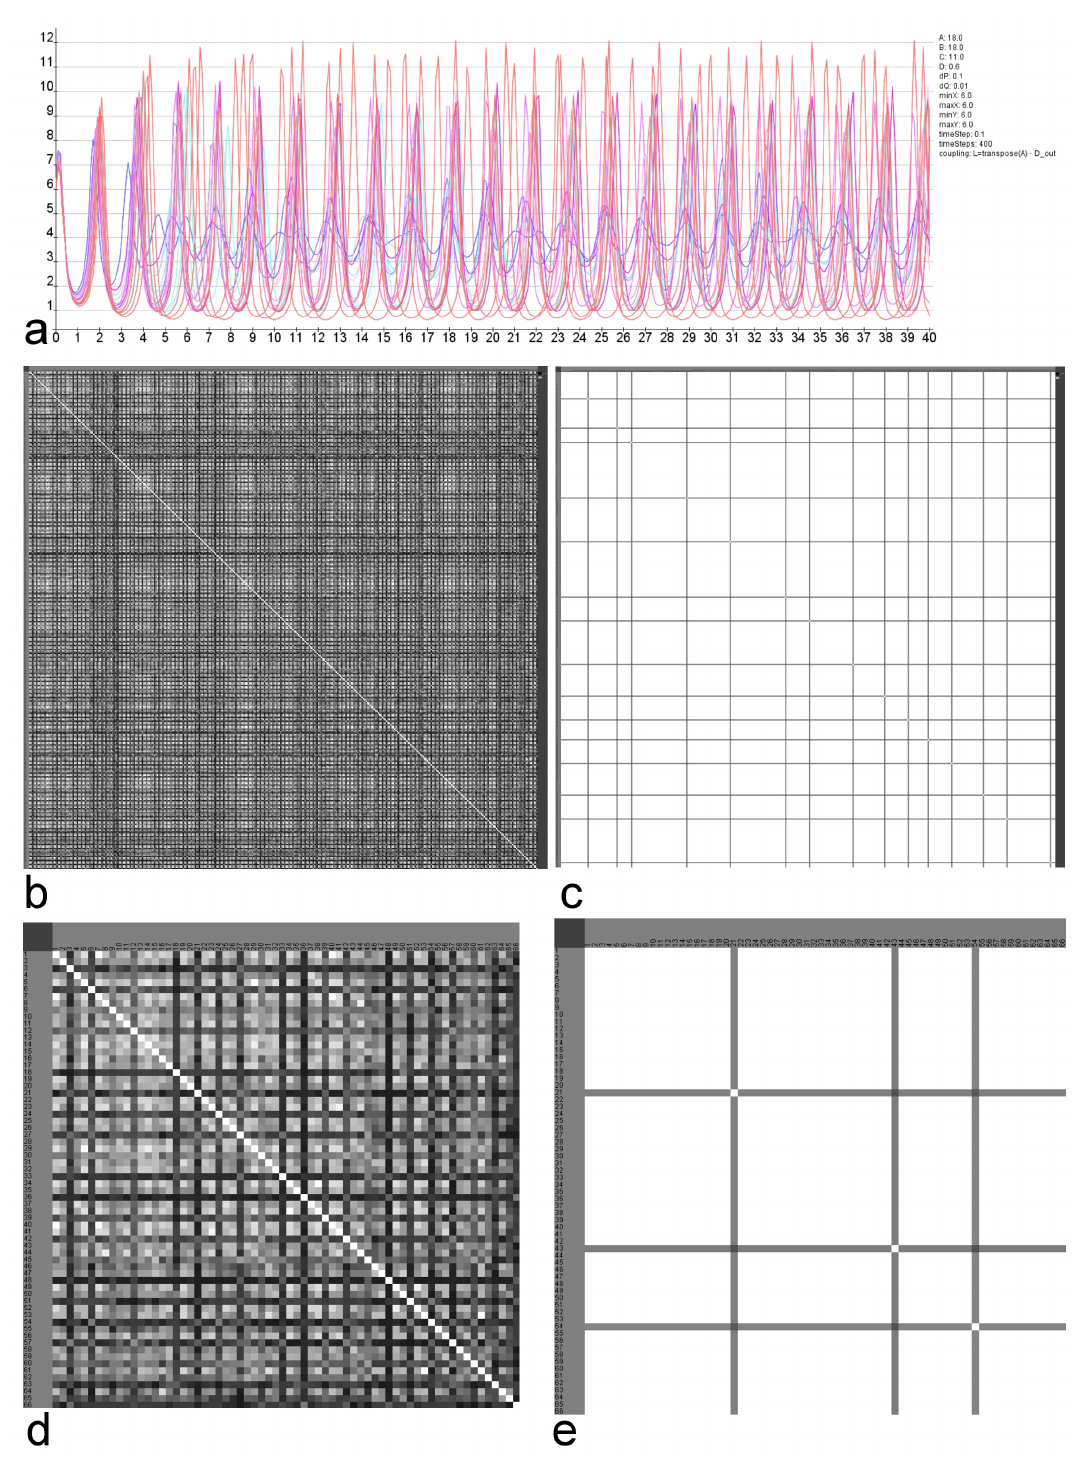
Fig 12. Similarities of clusterings referring MM parameter variation. The reaction parameters A-D were varied 375 times. a) RD functions of all regions using default parameters. b) Similarities of the clusterings using spectral clustering (Light: high similarity, dark low similarity). c) Similarities of the clusterings using Markov clustering (Light: high similarity, dark low similarity). d) Magnification of upper left corner of the matrix in b). e) Magnification of upper left corner of the matrix in c).